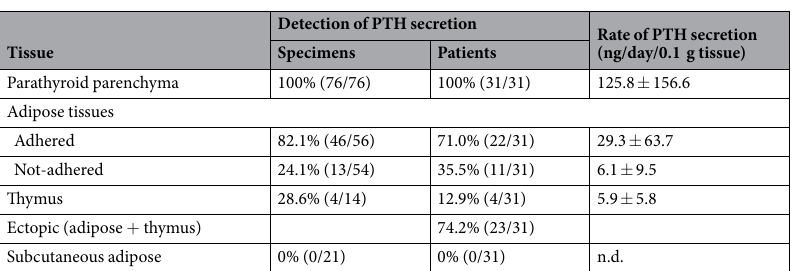
Table 1. PTH secretion in vitro by excised parathyroid parenchyma and adipose tissues. An iPTH secretion rate > 0.5 ng/day/0.1 g tissue was regarded as positive for PTH secretion in vitro . Detection of PTH secretion shows percentages of specimens or patients positive for PTH secretion in vitro and, in parentheses, the number of specimens or patients positive for PTH secretion in vitro over the number of total specimens or patients examined. Rate of PTH secretion is presented as mean ± SD. n.d., not